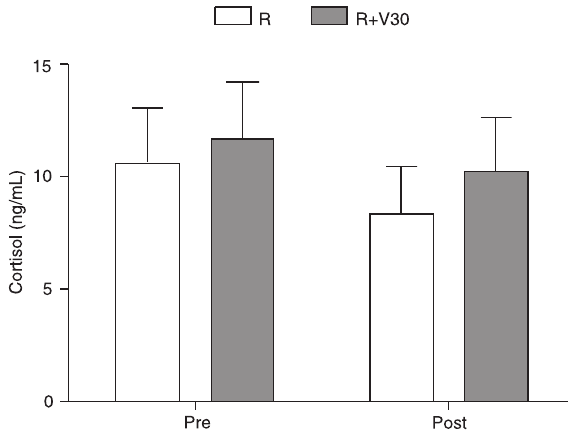
Figure 1. Salivary cortisol (ng/mL) before and immediately after the two exercise